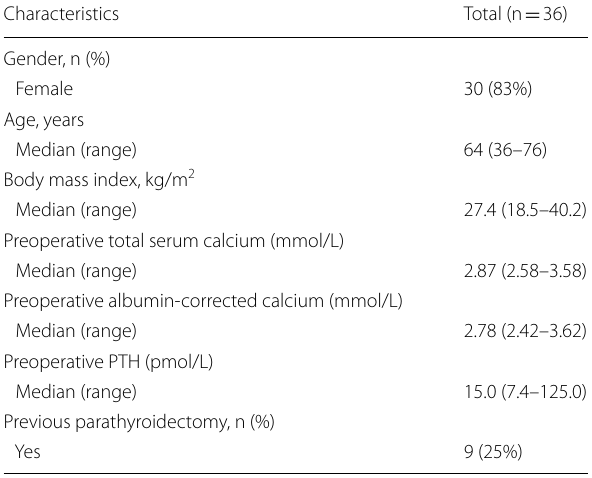
Table 1 Patients’ baseline characteristics